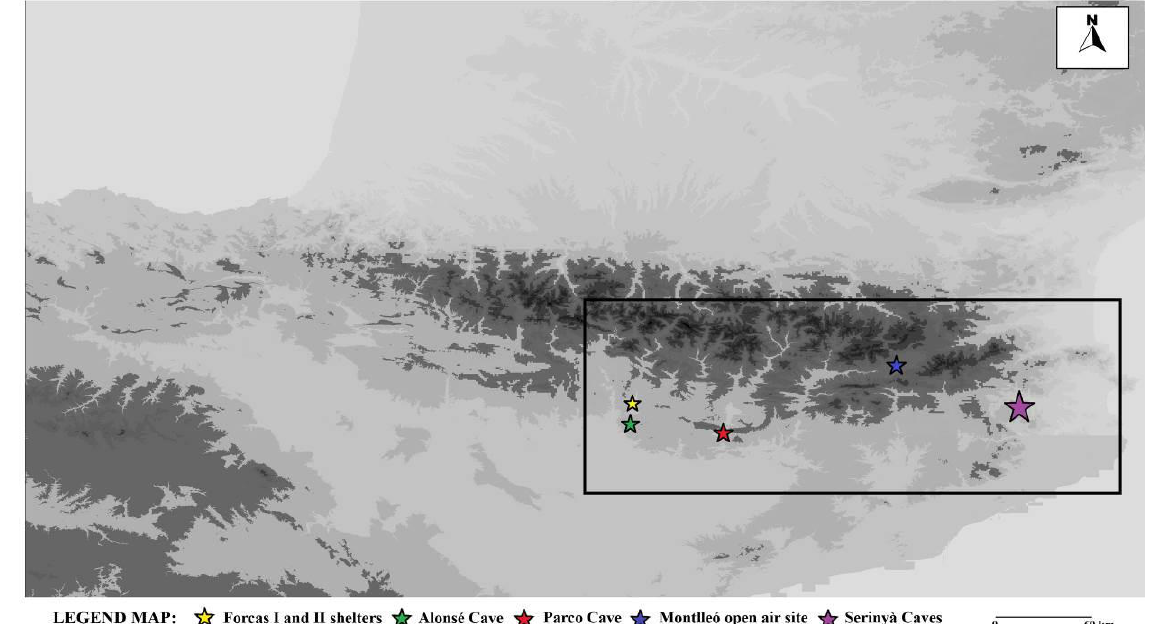
Figure 6. Map of the archaeological sites that are related with the Pyrenees